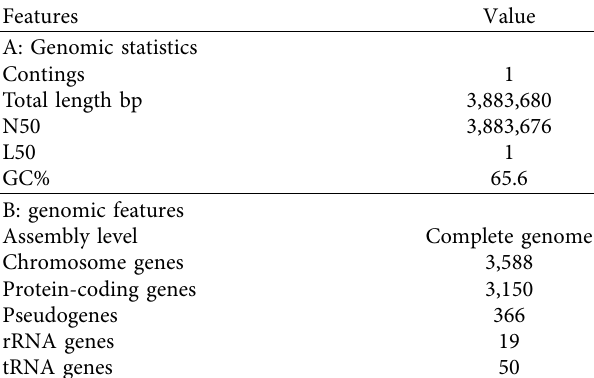
Table 1: Genomic features of Arthrobacter sp.